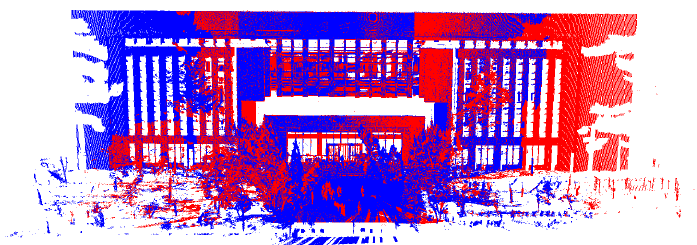
Figure 24. The final registration results. Red part is the target point cloud, and blue part is the point cloud to be matched.